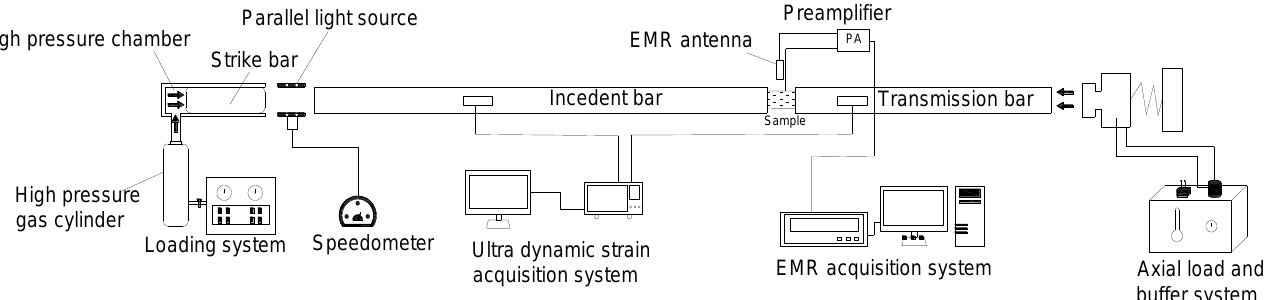
Figure 1. Schematic diagram of the experimental system.